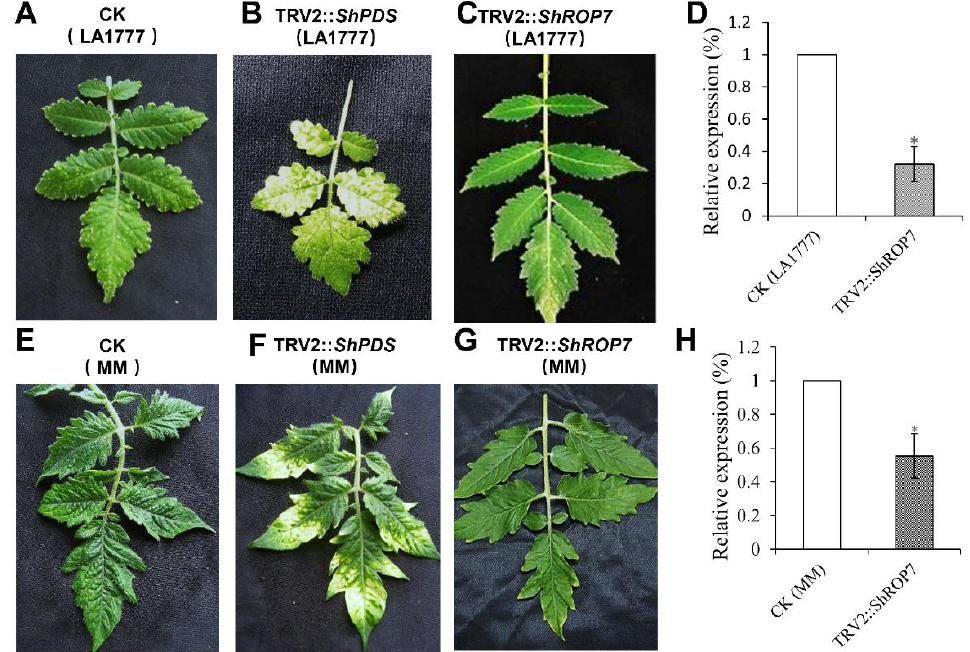
Figure 4. Silencing of ShROP7 by TRV-VIGS. Phenotypes of control (CK) ( A ), TRV2:: ShPDS ( B ) and TRV2:: ShROP7 ( C ) tomatoes after 30 days post-infection with Agrobacterium . ( D ) Expression level of ShROP7 in silenced plants (LA1777). Phenotypes of CK (control) ( E ), TRV2:: ShPDS ( F ) and TRV2:: ShROP7 ( G ) tomatoes after 30 days post infected with Agrobacterium in MM plants. ( H ) Expression level of ShROP7 gene in silenced plants (MM). The asterisk (*) indicate